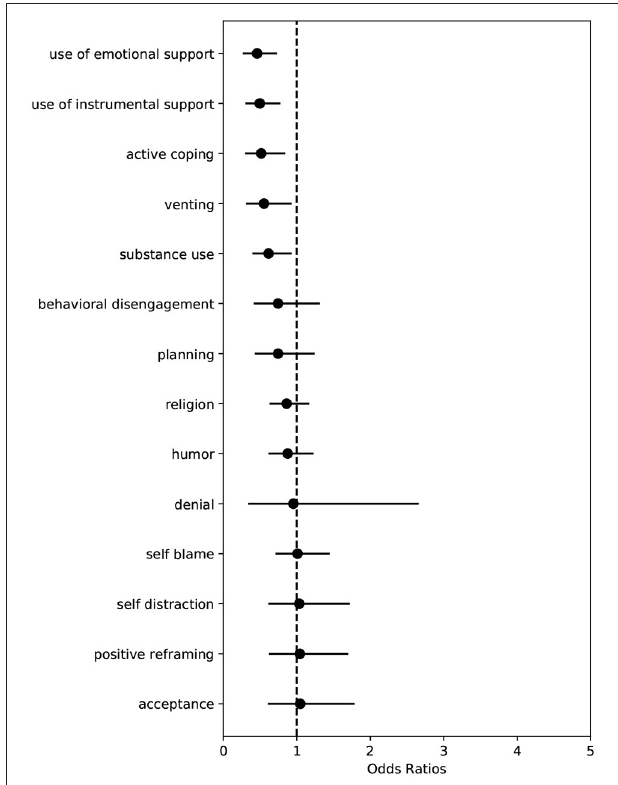
FIGURE 5 | Coefficients plot of COPE measures associated with response cluster. Points indicate median effect size and black horizontal lines indicate the range of the 90% credible interval.